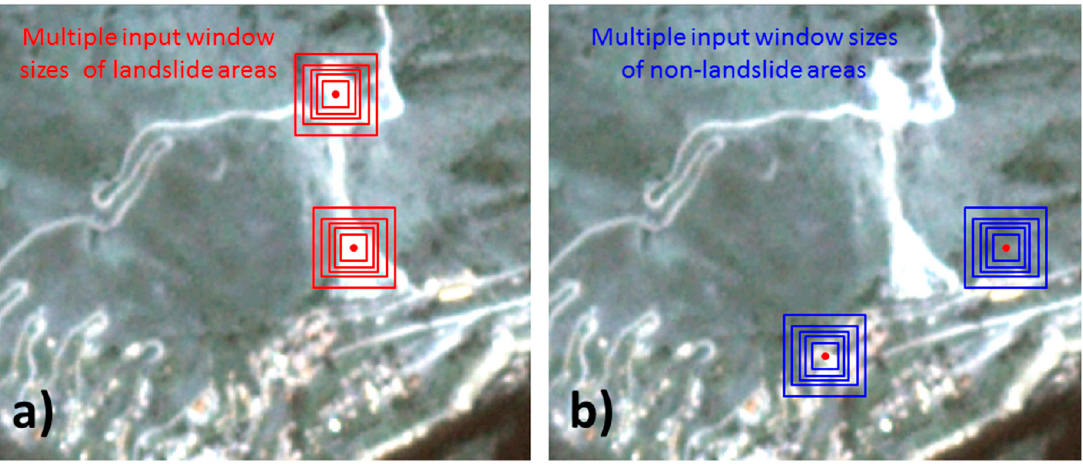
Figure 4. The multiple CNN input window sizes for (a) landslide and (b) non-landslide areas.